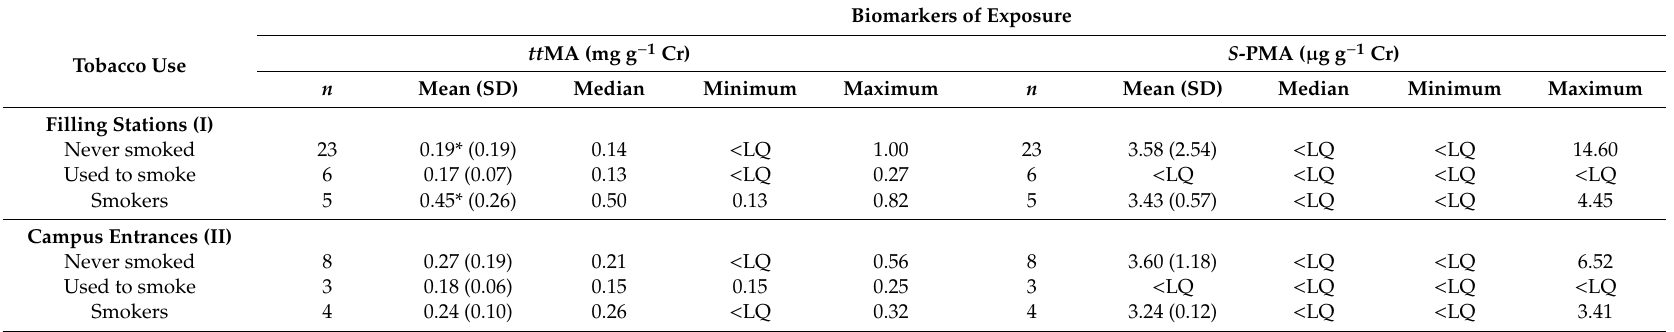
Table 3. Results of biomarkers of exposure to benzene and of the variable tobacco use in both groups of workers. Biomarkers of